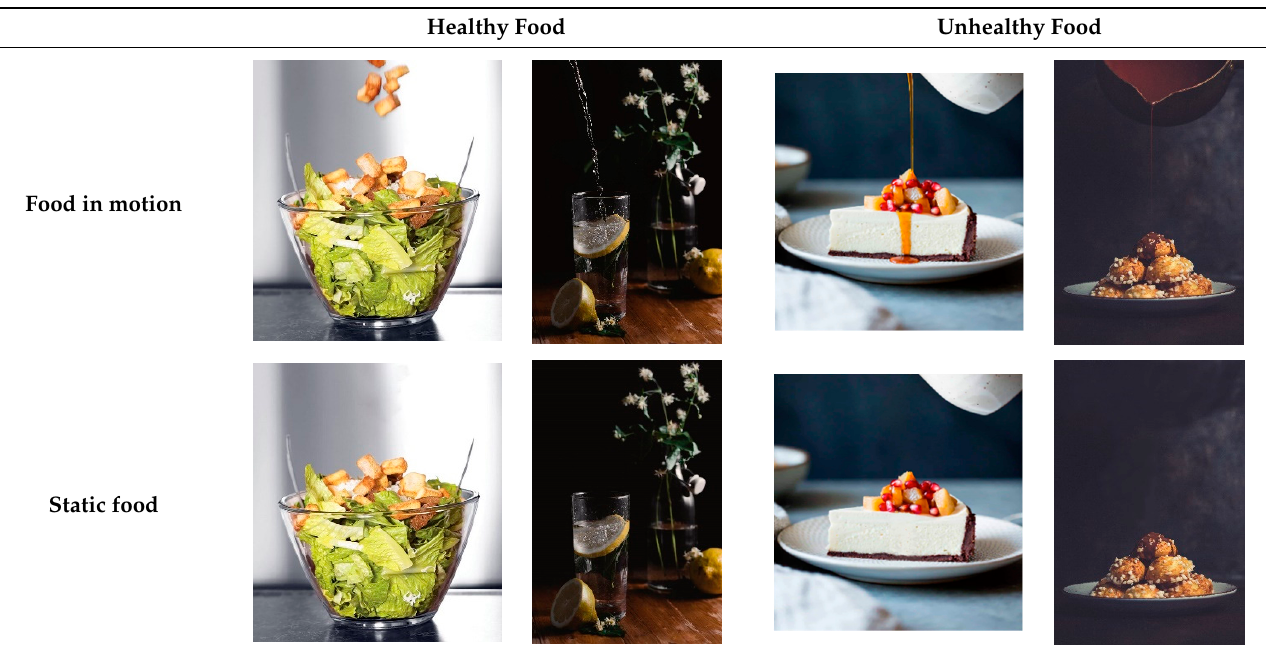
Table 6. Examples of the food stimuli used in Study 2b.